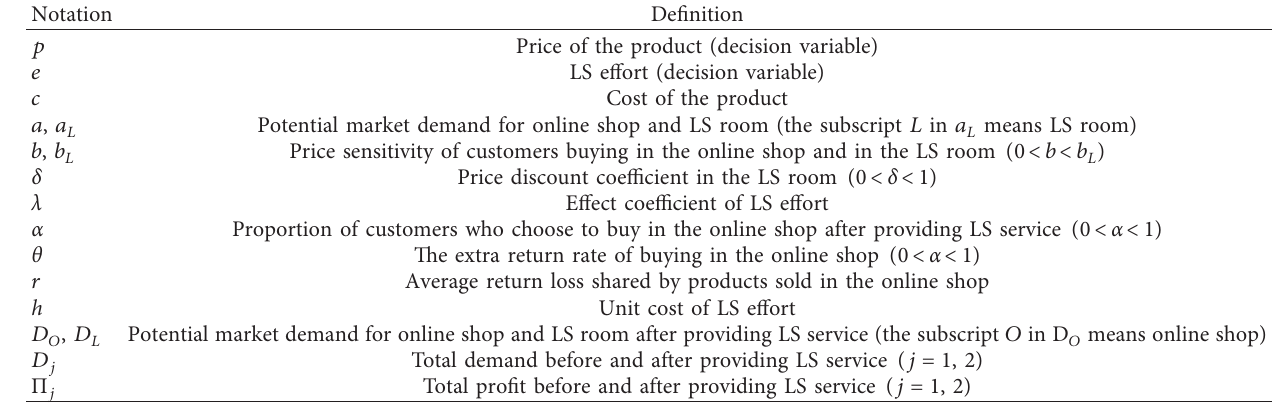
Table 1: Notations and